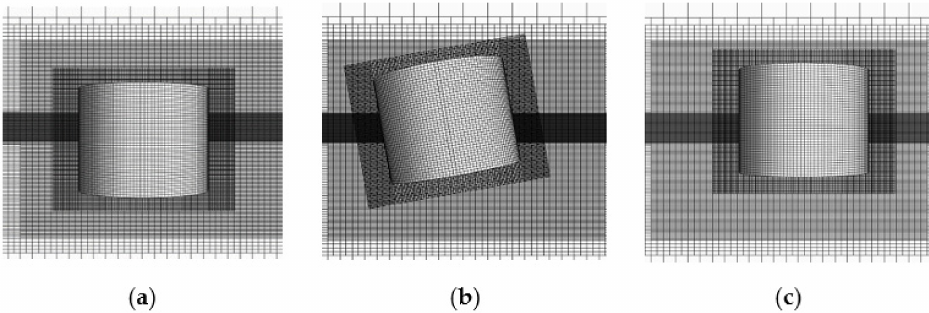
Figure 2. The overset grid schemes for: ( a ) heave; ( b ) pitch; ( c ) and surge.